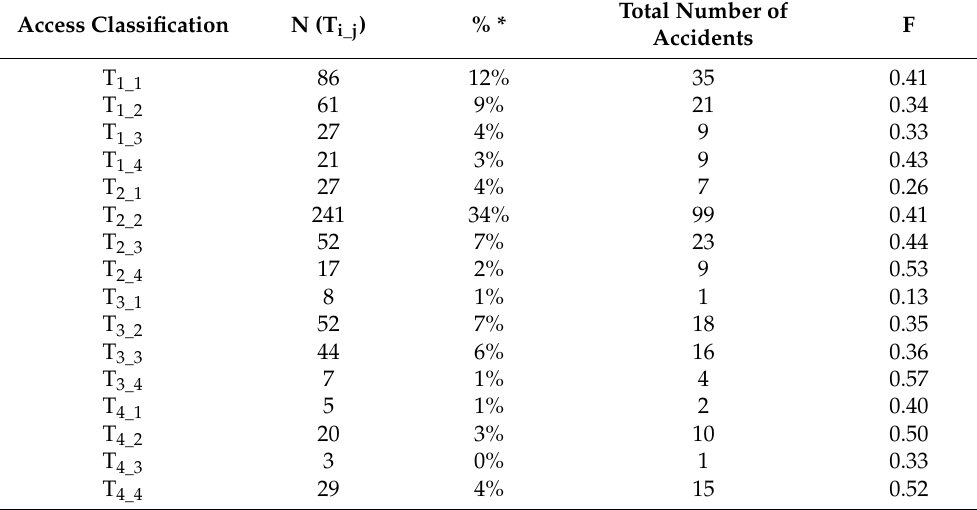
Table 7. Aggregate analysis (rural and urban areas) related to all the subsets of classes. % * is the percentage of access points of the same subclass type compared to the total number of accesses that were noted.